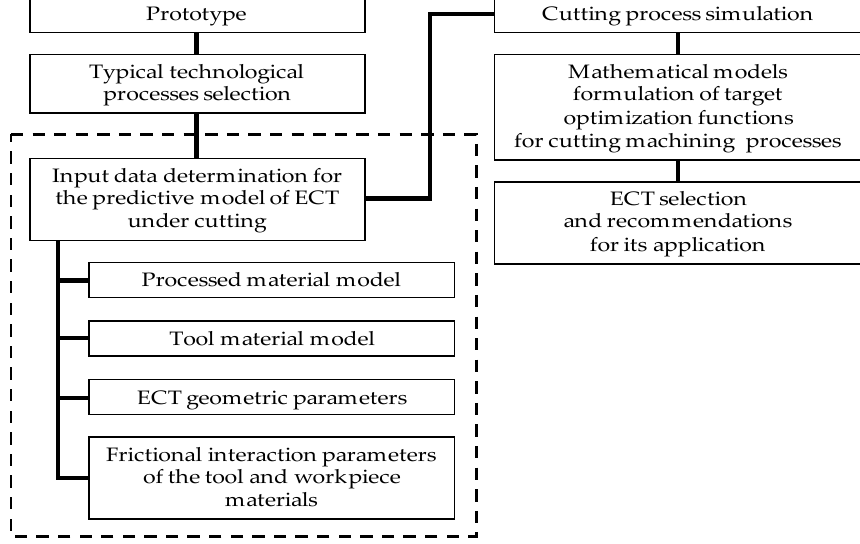
Figure 2. A generalized model of the edge cutting tools choice to ensure optimal cutting conditions.